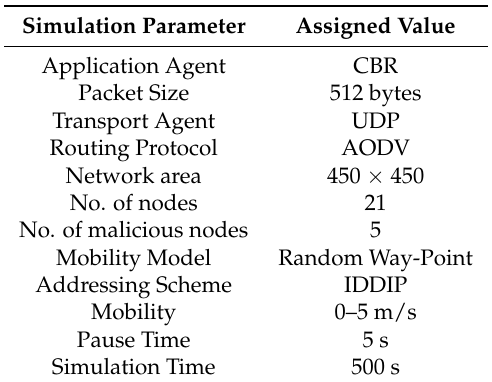
Table 1. Simulation parameters and